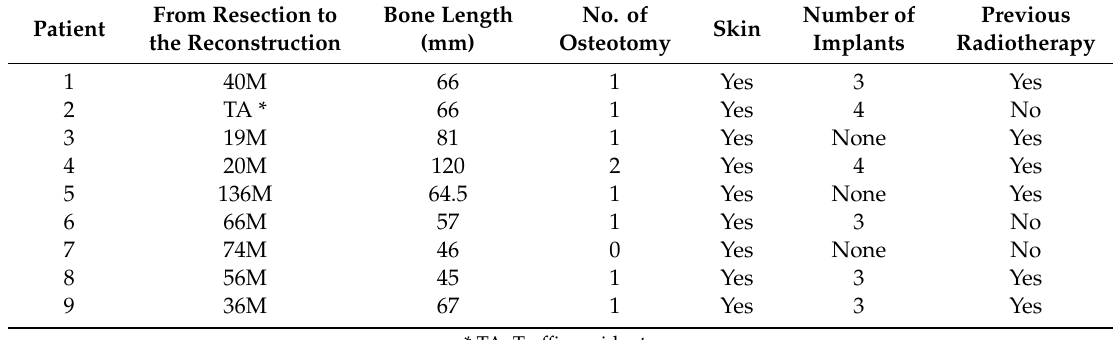
Table 2. Clinical outcomes after the reconstruction of palatomaxillary defect.